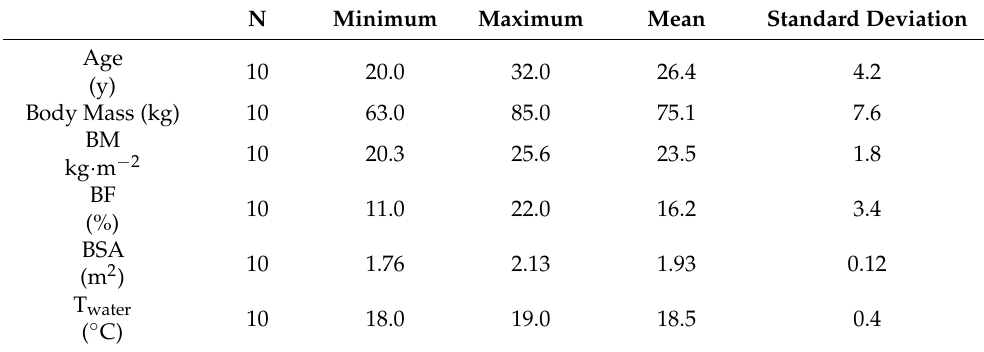
Table 1. Descriptive statistics of the study